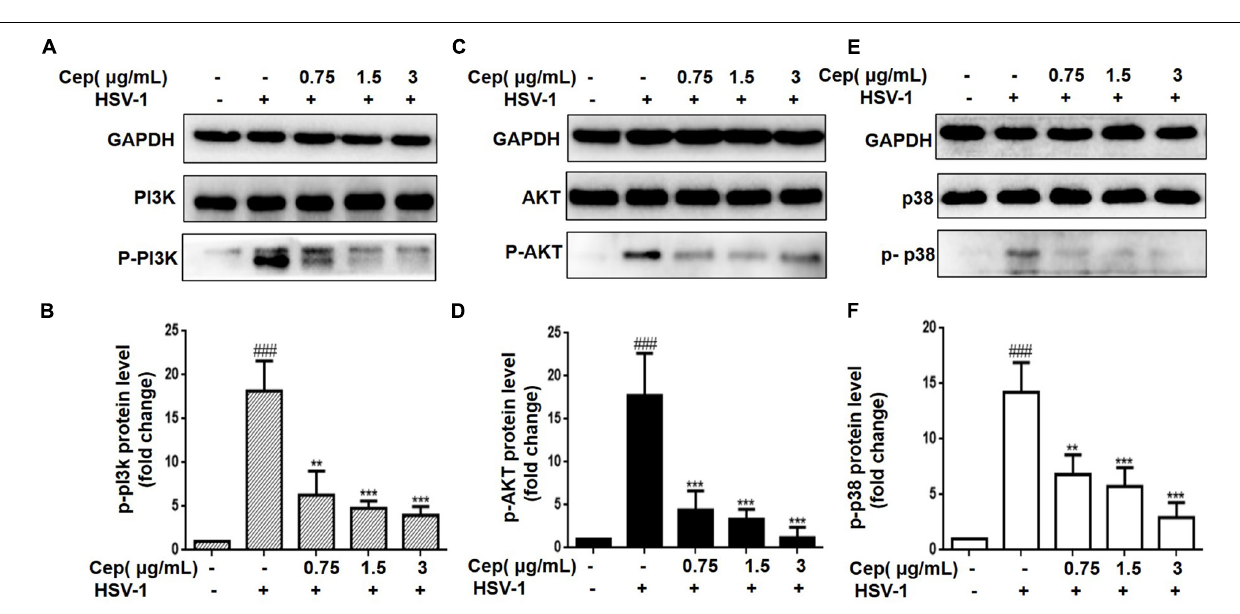
Frontiers in Microbiology |